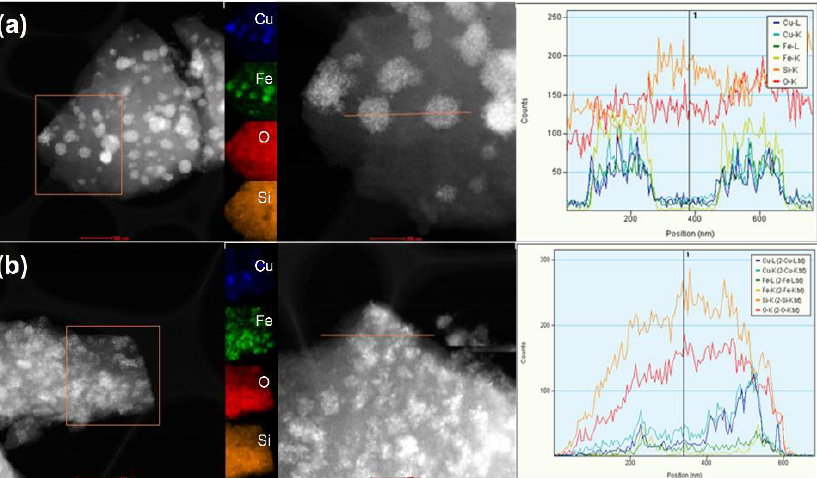
Figure 5. HADDF-STEM and elemental mapping images of the CuFe/SiO 2 samples: (a) CuFe/SiO 2 - and ( b ) CuFe/SiO 2 N and (b) CuFe/SiO 2 -T.